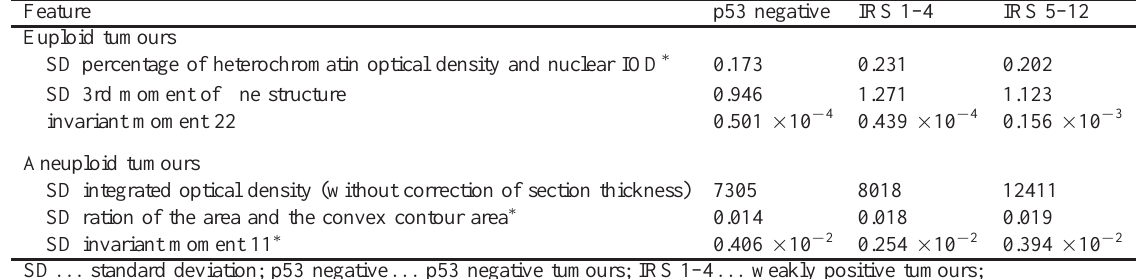
Significantly different features in euploid (di- and tetraploid) and aneuploid tumours with different p53 expression ( p < 0 . 05 )